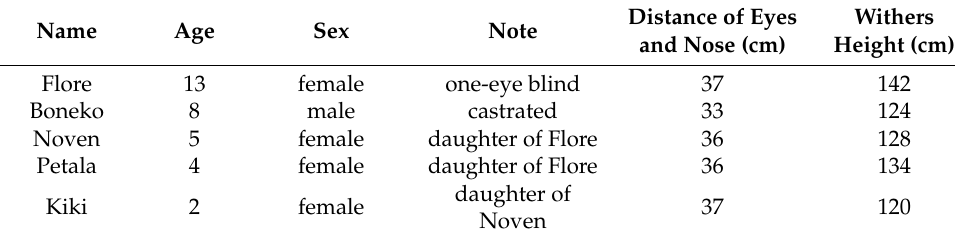
Table 1. Details of the participant horses. Name and gender of each horse participant. Additional information on the link between each horse and their visual status is given in the Notes column. The Distance eyes/nose for each horse is defined by the distance from the center of the eyeball to the nose tip in the side view. The distance can impact the discrimination study using the touchscreen. The measure of the withers height is indicated for each participant. It was important to choose the distance between the entrance barrier and the